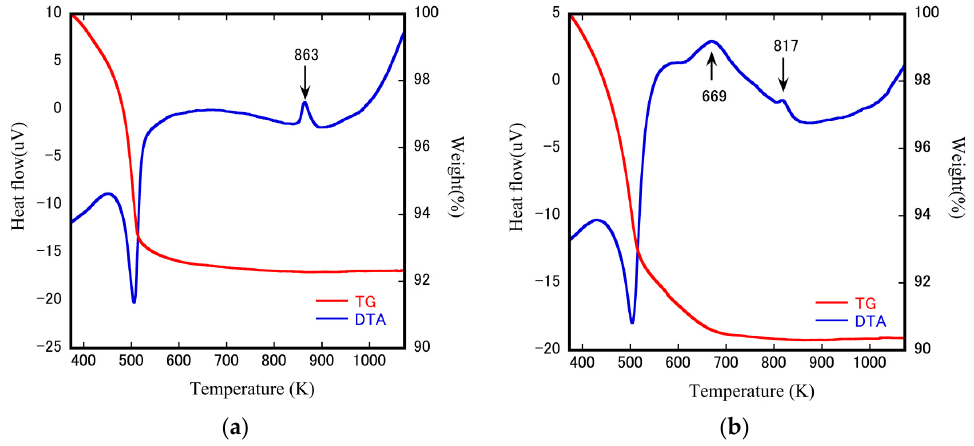
Figure 2. TG-DTA curves of the ZrW 2 − x Mo x O 7 (OH) 2 · 2H 2 O ( a ) x = 0.0; ( b ) x = 1.0